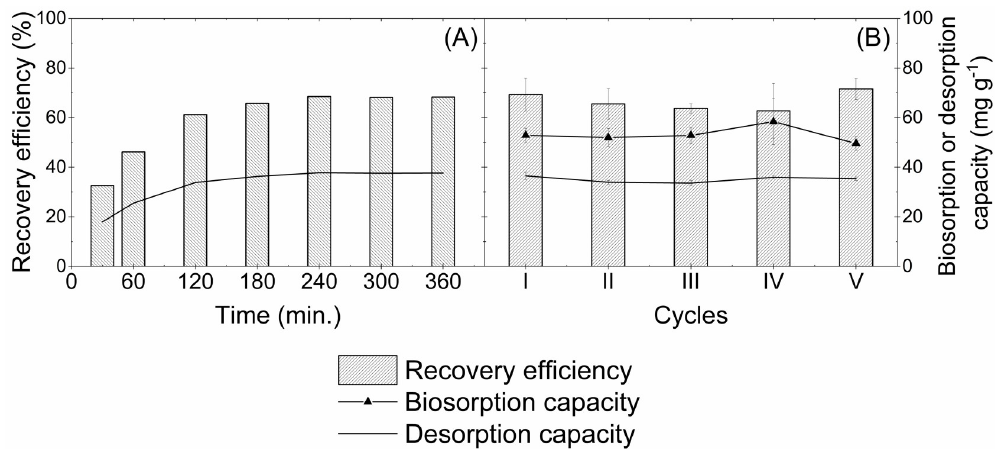
Fig 7. Desorption kinetics (A), biosorption/desorption capacity and copper recovery efficiency in successive cycles (B) by EB30. Conditions: Initial copper concentration = 750 mg L -1 ; pH = 5.0; biosorbent dosage for EB30 = 1.0 g L -1 , desorbing agent = HCl (0.05 mol L -1 ); contact time of 240 min; agitation speed = 150 rpm; temperature = 25 ± 2˚C.